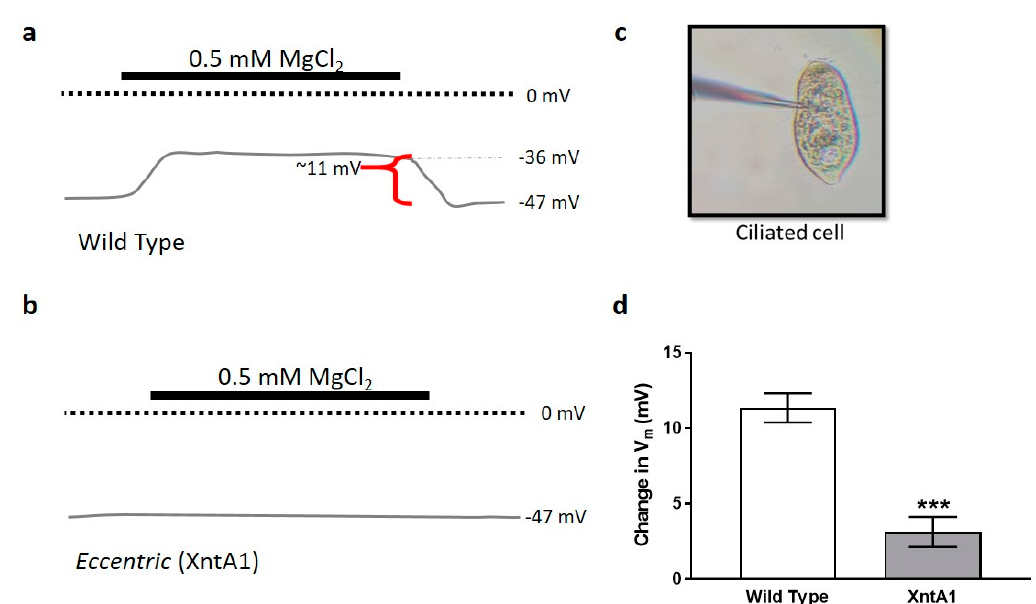
Figure 4. Membrane potential recordings show wild type cells are permeable to Mg 2 + while XntA1 mutants are not. ( a ) Schematic representation of membrane potential recordings from wild type (WT) and ( b ) XntA1 mutants in 1 mM KCl, then 0.5 mM MgCl 2 with 1 mM KCl, then returning to 1 mM KCl. Concentration of KCl (1 mM) remains consistent throughout the recordings, only the concentration of Mg 2 + changes. Typical resting membrane potential of Paramecium (WT or XntA1) in 1 mM KCl is ~ − 47 mV. In the presence of 0.5 mM MgCl 2 , the membrane potential of WT cells depolarizes by ~11 mV while the XntA1 mutants show almost no change. ( c ) An XntA1 mutant during membrane potential recording. ( d ) As expected, wild type cells depolarize by 11.4 mV ± 2.7 (N = 9), significantly more than XntA1 mutants (3.1 mV ± 3.2, N = 11) in the presence of 0.5 mM MgCl 2 (*** = p < 0.0001; T-test).